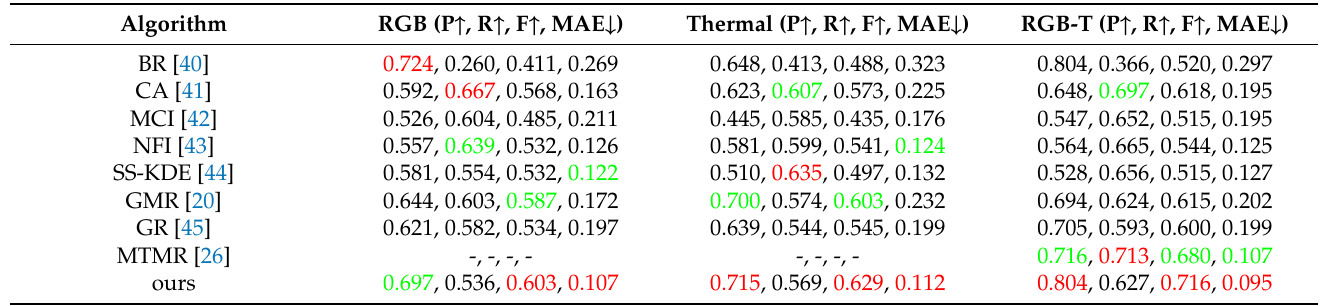
Table 2. Average precision (P), recall (R), F-measure (F) and mean absolute error (MAE) of our method against different kinds of methods on the RGBT-Saliency dataset. In the evaluation parameters, the larger the value of P, R, and F, the better the detection effect, while the smaller the value of MAE, the better the effect. The red font indicates the best performance. The green is second best.